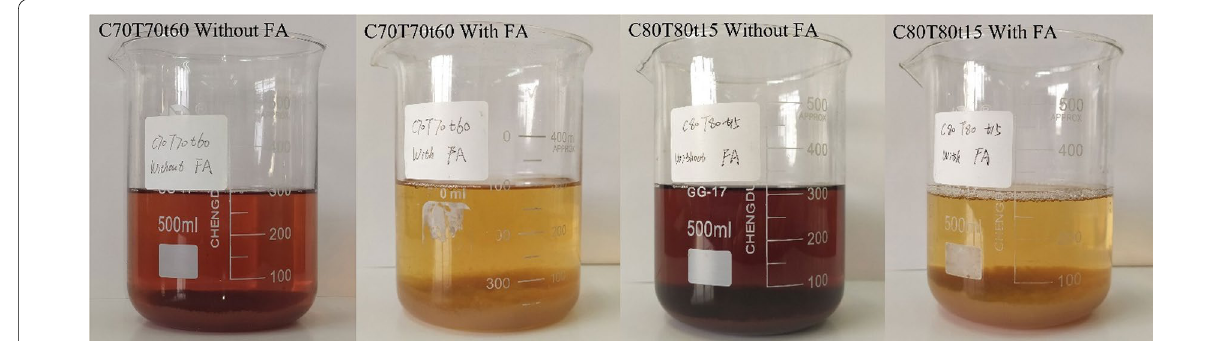
Fig. 3 Morphology comparison of the extracted lignin with and without FA addition after 12 h storing